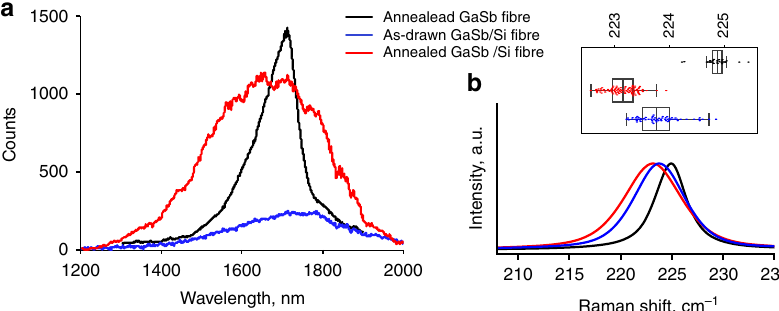
Fig. 3 Photoluminescence and strain results. a Room temperature emission from an annealed GaSb fi bre (black, reduced 2.5 times), with PL from as-drawn (blue) and spot-annealed (red) regions of a composite GaSb/Si fi bre. b Raman spectra for GaSb the same fi bres, showing tensile strain in the composite fi bres and peak broadening. The inset shows statistical information on the peak positions; the box width is one standard deviation and the end bars are at three. Coloured dots show the